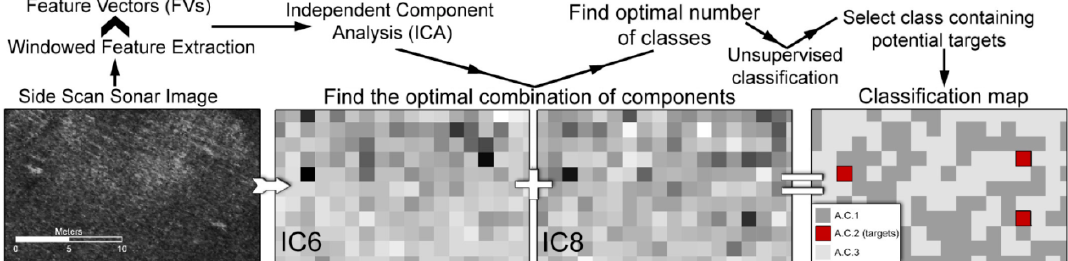
Figure 1. Overview of the proposed methodological scheme for automatic target detection in Side Scan Sonar (SSS) imageries using feature based acoustic classification and Independent Component Analysis (ICA). IC6 and IC8 correspond to the 6th and 8th Independent Components of the Feature Vectors (FVs).